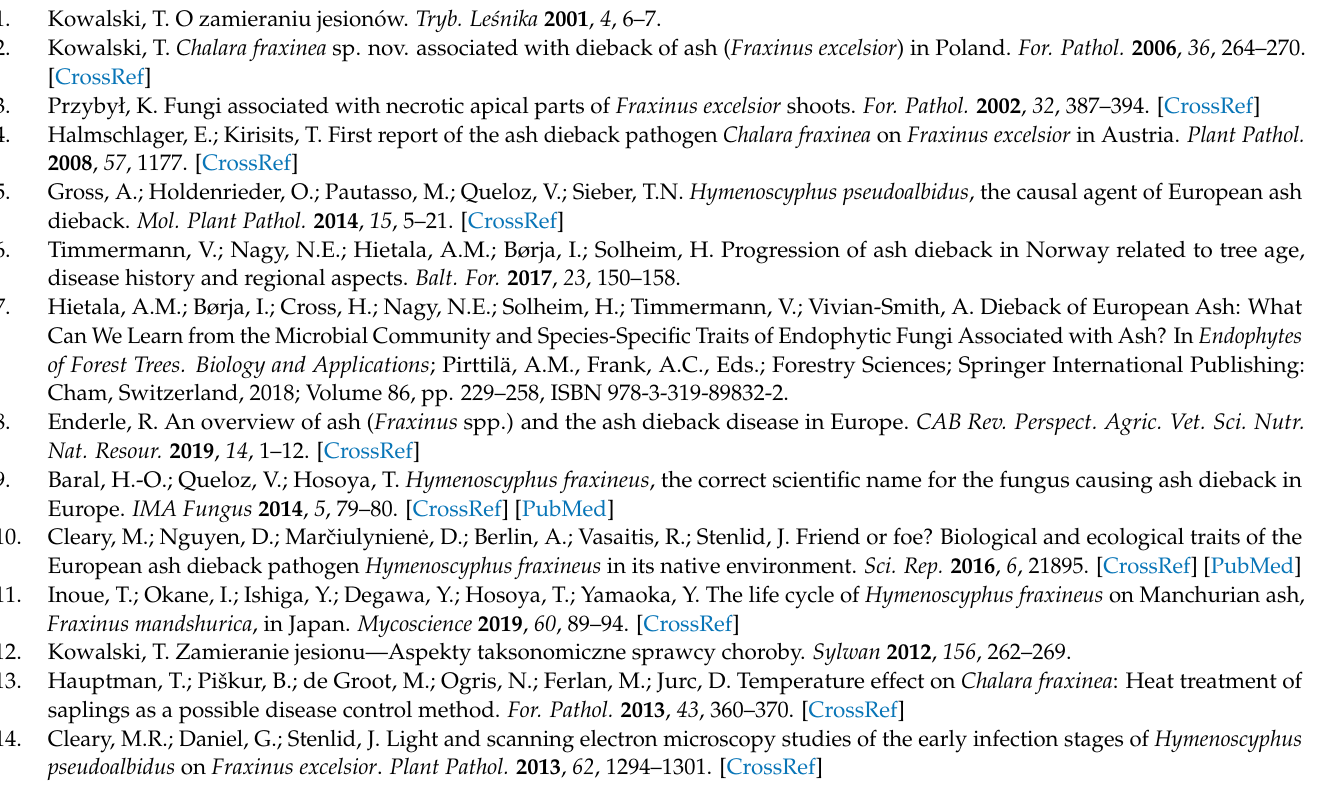
Figure S3: Similarity of fungal communities detected in situ from fruit bodies on the previous year’s leaf petioles of F. excelsior in five stands shown by dendrogram based on Bray–Curtis similarity index; Figure S4: Network of co-occurrence of fungi detected in situ from fruit bodies on the previous year’s leaf petioles of Fraxinus excelsior in five stands, in southern Poland, determined on the basis of data grouped for the study plots. Each connection shows a strong (Spearman’s p > 0.6) and significant ( p < 0.05) correlation. Blue lines indicate positive correlation. The same color represents fungal taxa with potential co-occurrence in the same module. The frequency of the species was indicated by the size of each